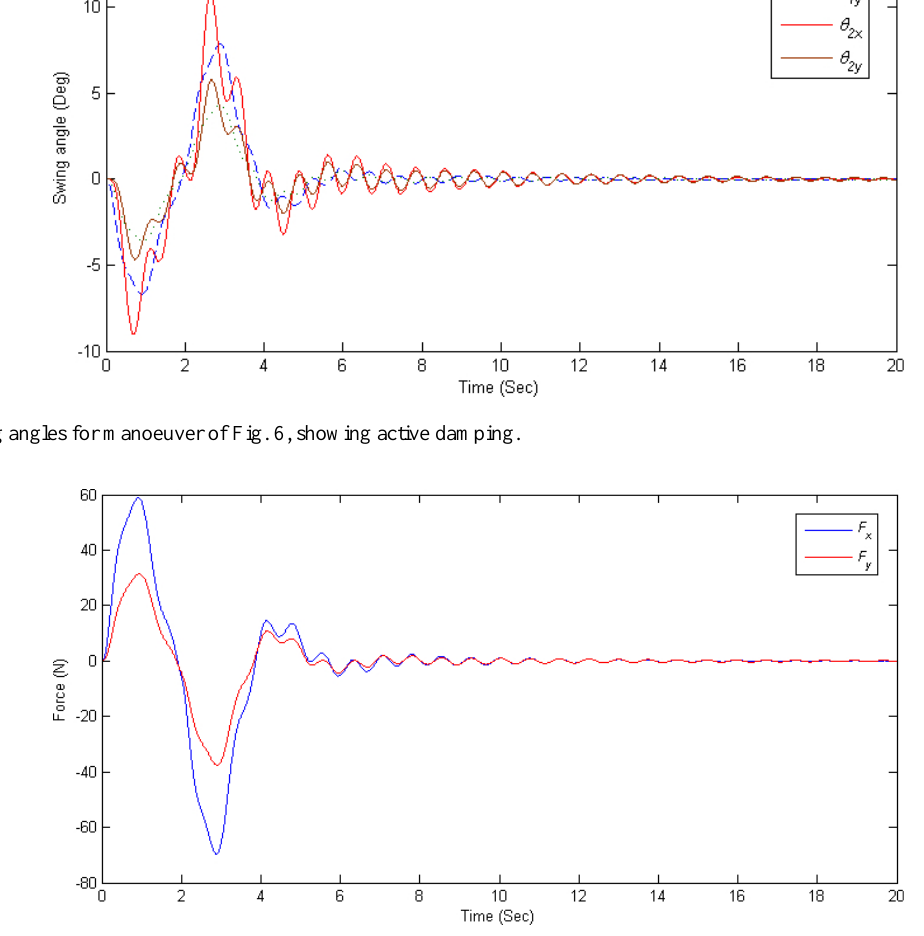
Figure 8. Reduction of forces acting on trolley through WBC